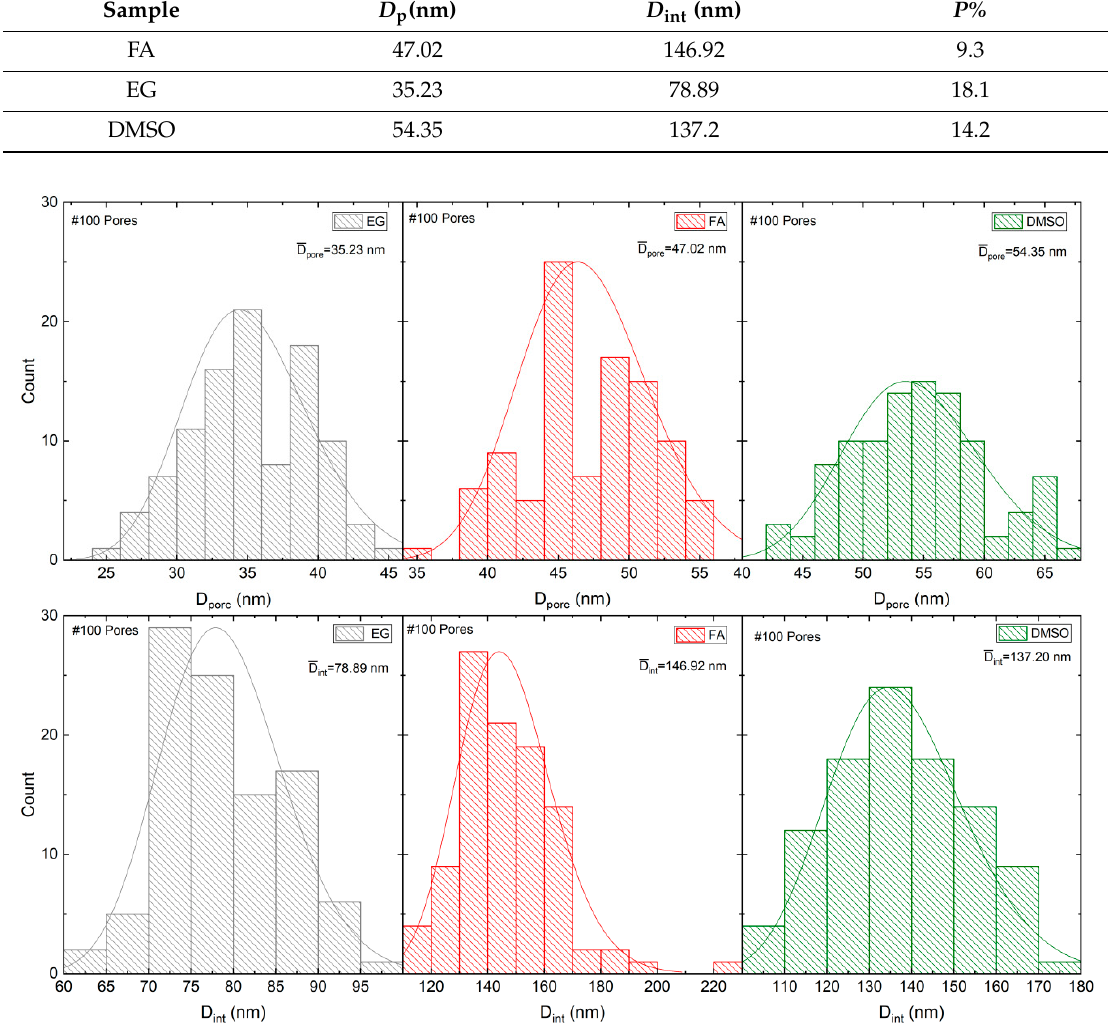
Figure 9. Histograms of the size distribution, D p and D int , which were fitted with a normal distribution for samples EG, FA and DMSO.